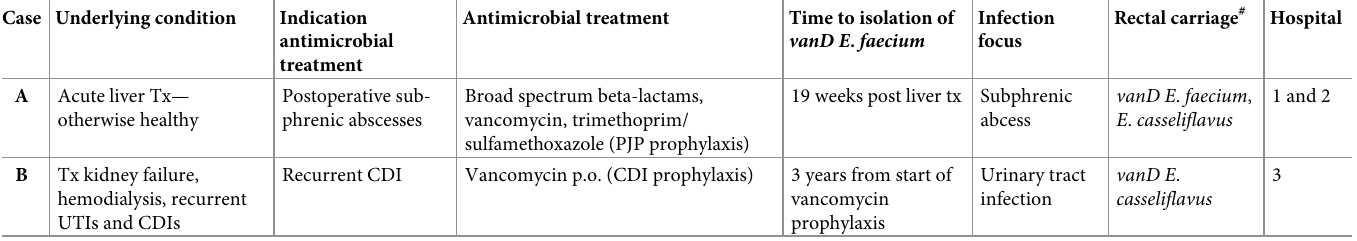
Table 1. Relevant case